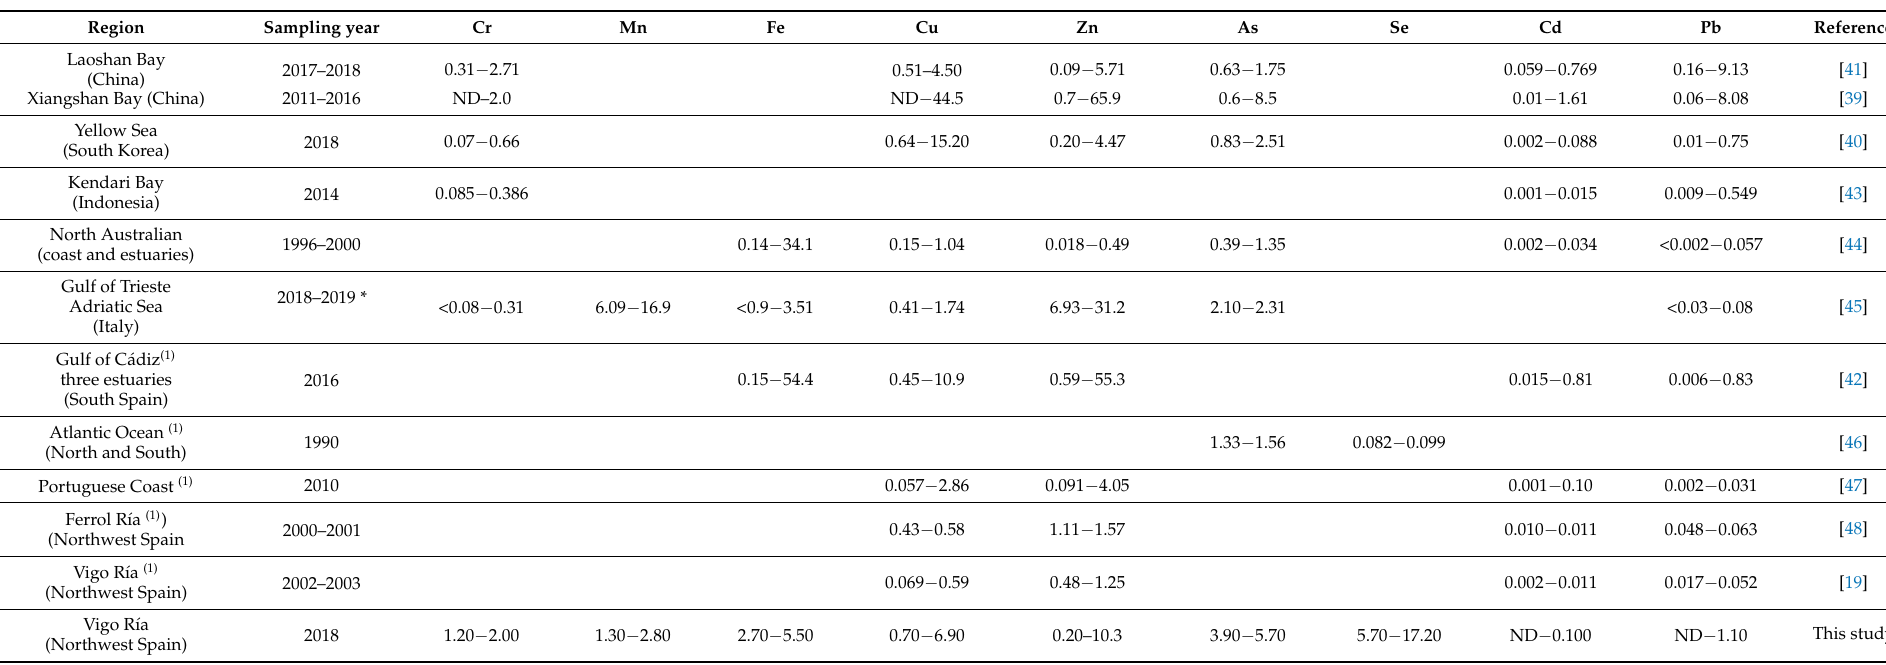
Table 3. Concentration ranges ( µ g L − 1 ) of dissolved heavy metals in different coastal areas of the